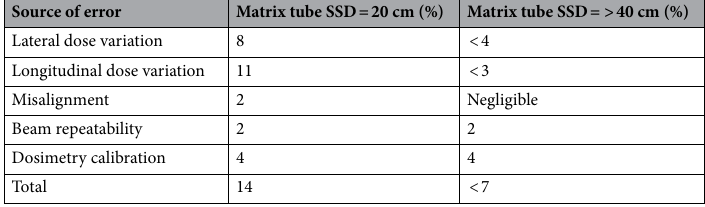
Table 3. Uncertainty budget for dicentric study.